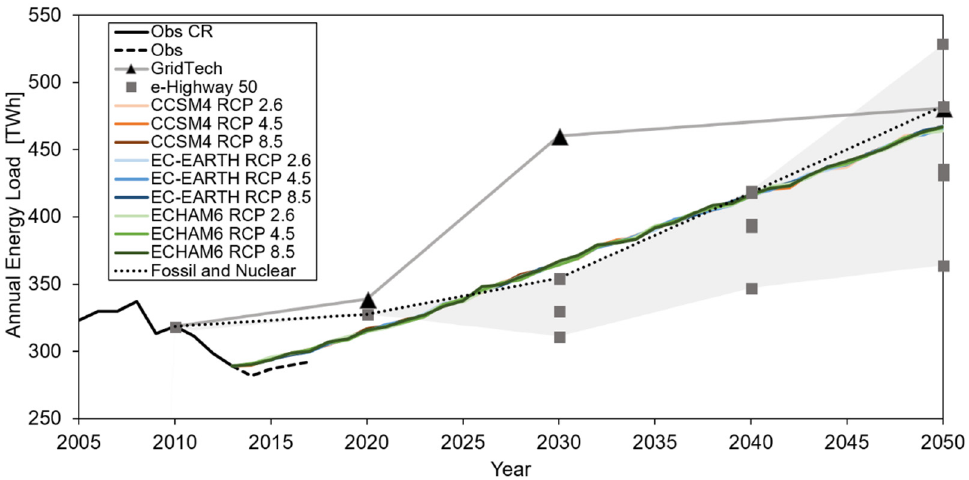
Figure 6. Annual load. Observed and projected values at 2050 for benchmarking against the results from GridTech and e-Highway 2050 projects.